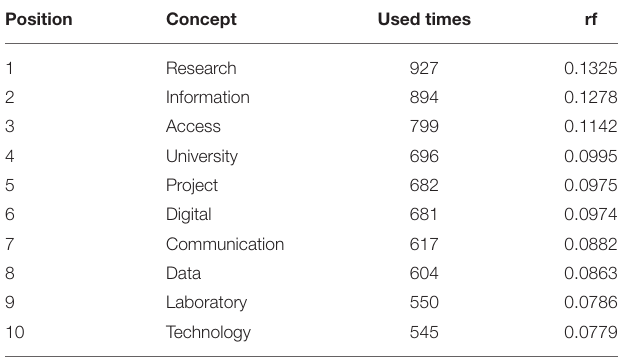
TABLE 2 | Ten most frequent terms shared by